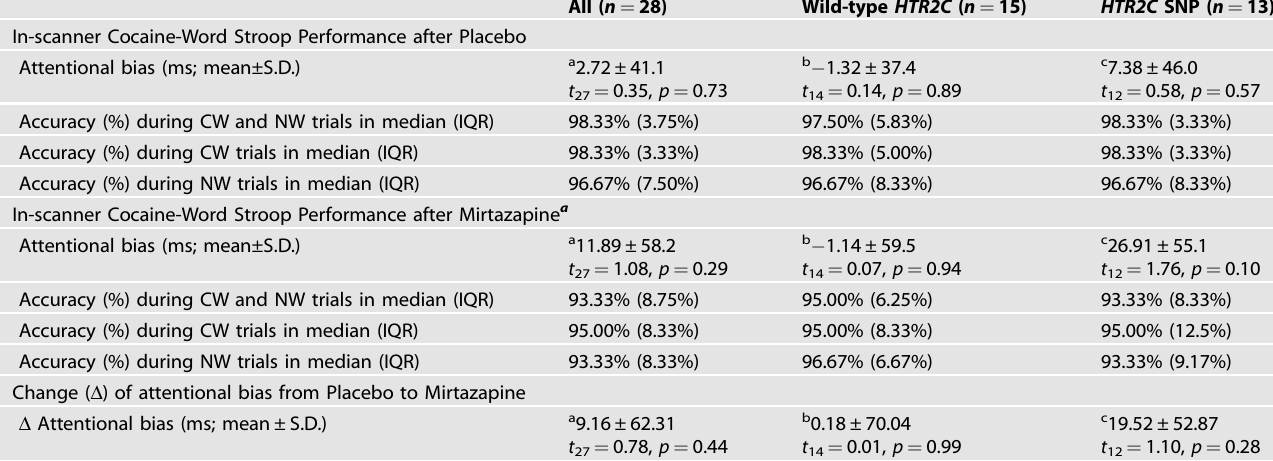
Table 2. In-scanner behavior under placebo and mirtazapine